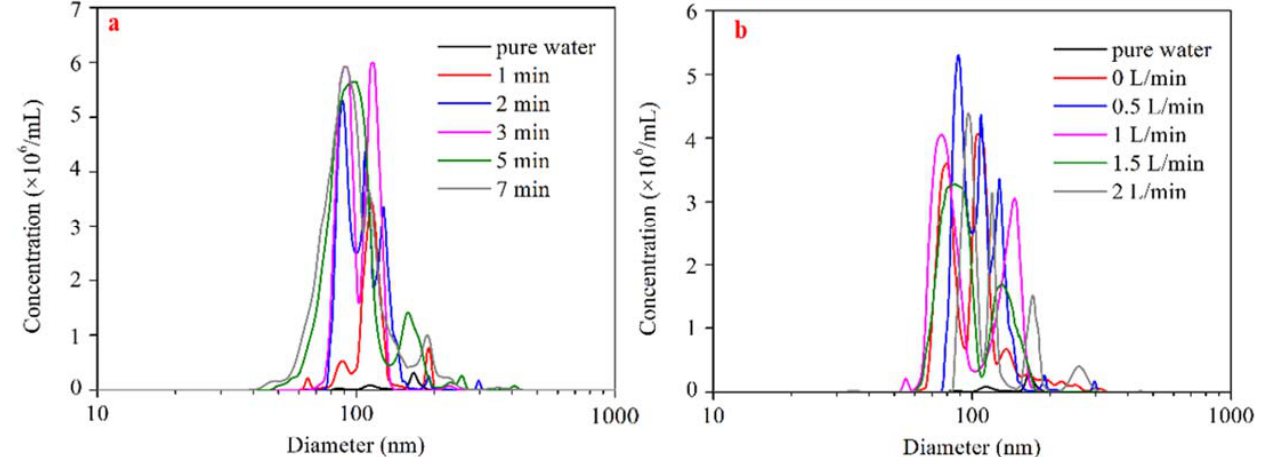
Figure 8. Size distribution of BMBs prepared under different conditions: ( a ) 0.5 L/min aeration rate, ( b ) 2 min preparation time.